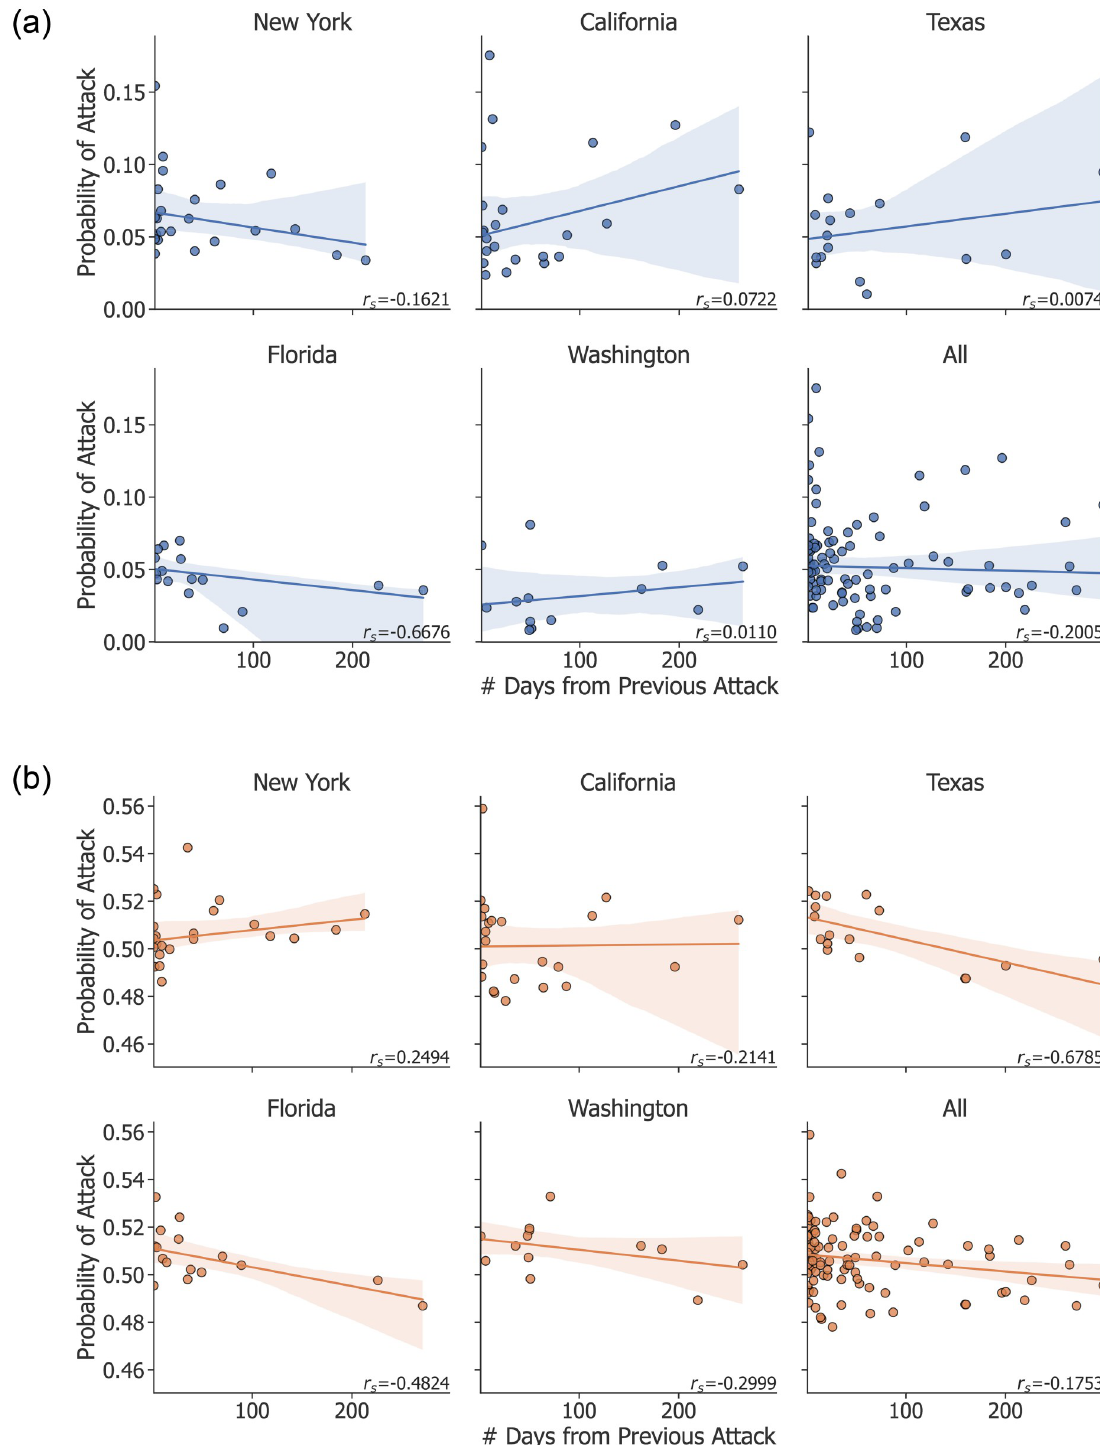
Fig 4. Predicted probabilities for each attack. The probabilities for RF (top, blue) and FFNN (bottom, yellow) are plotted as a function of distance in time from the previous attack in that state. The shaded region is the confidence interval for the regression line, and r s is Spearman’s rank correlation coefficient. The difference in scale in the y-axis between RF and FFNN is caused by differences in the training process for each model.